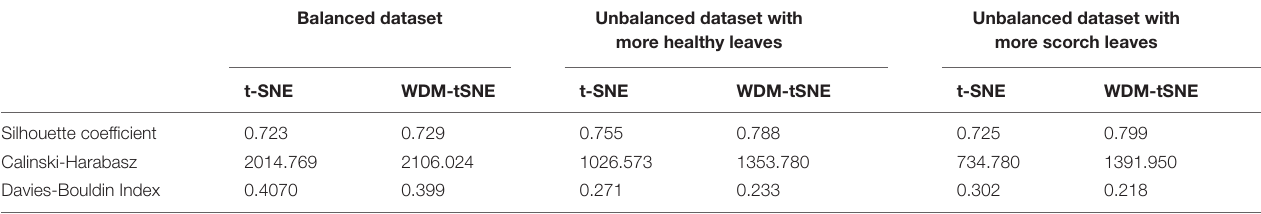
Unbalanced dataset with more scorch